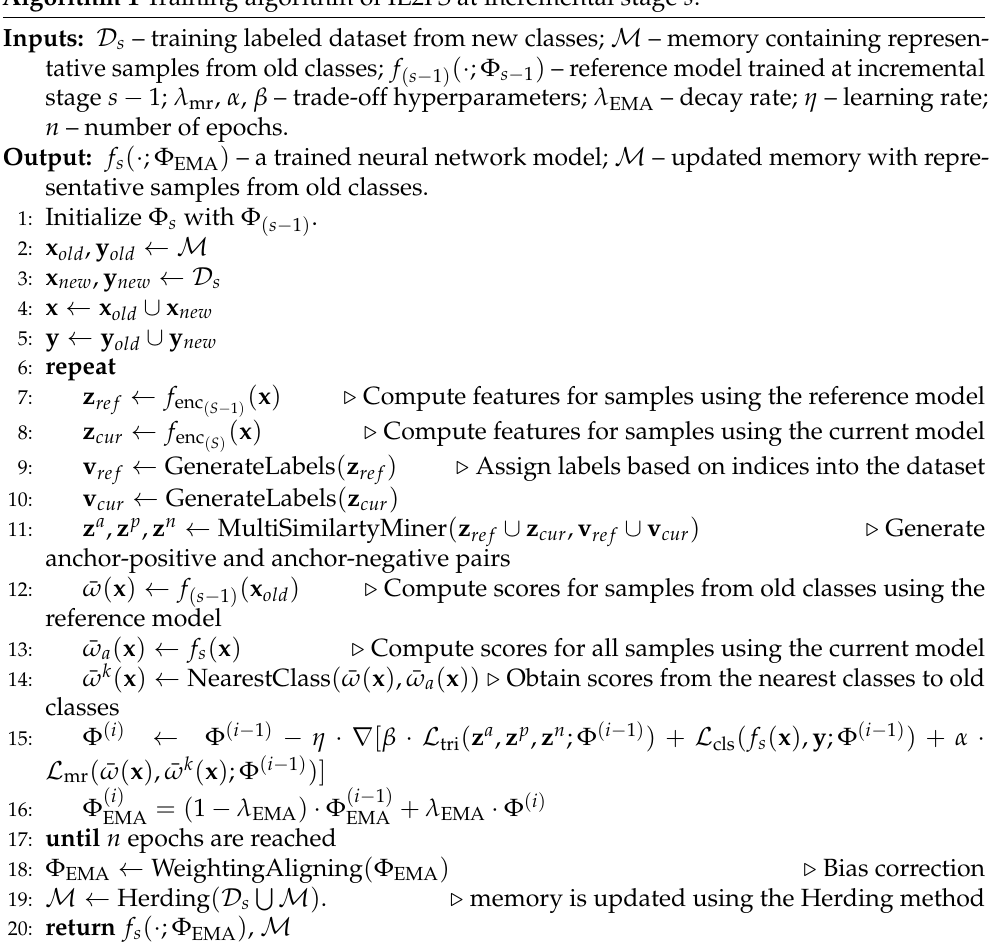
Algorithm 1 Training algorithm of IL2FS at incremental stage s